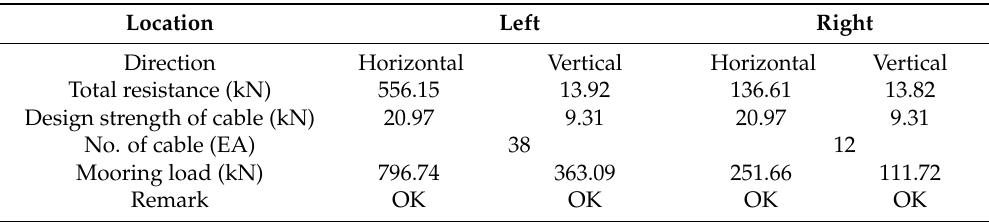
Table 7. Result of mooring system design.